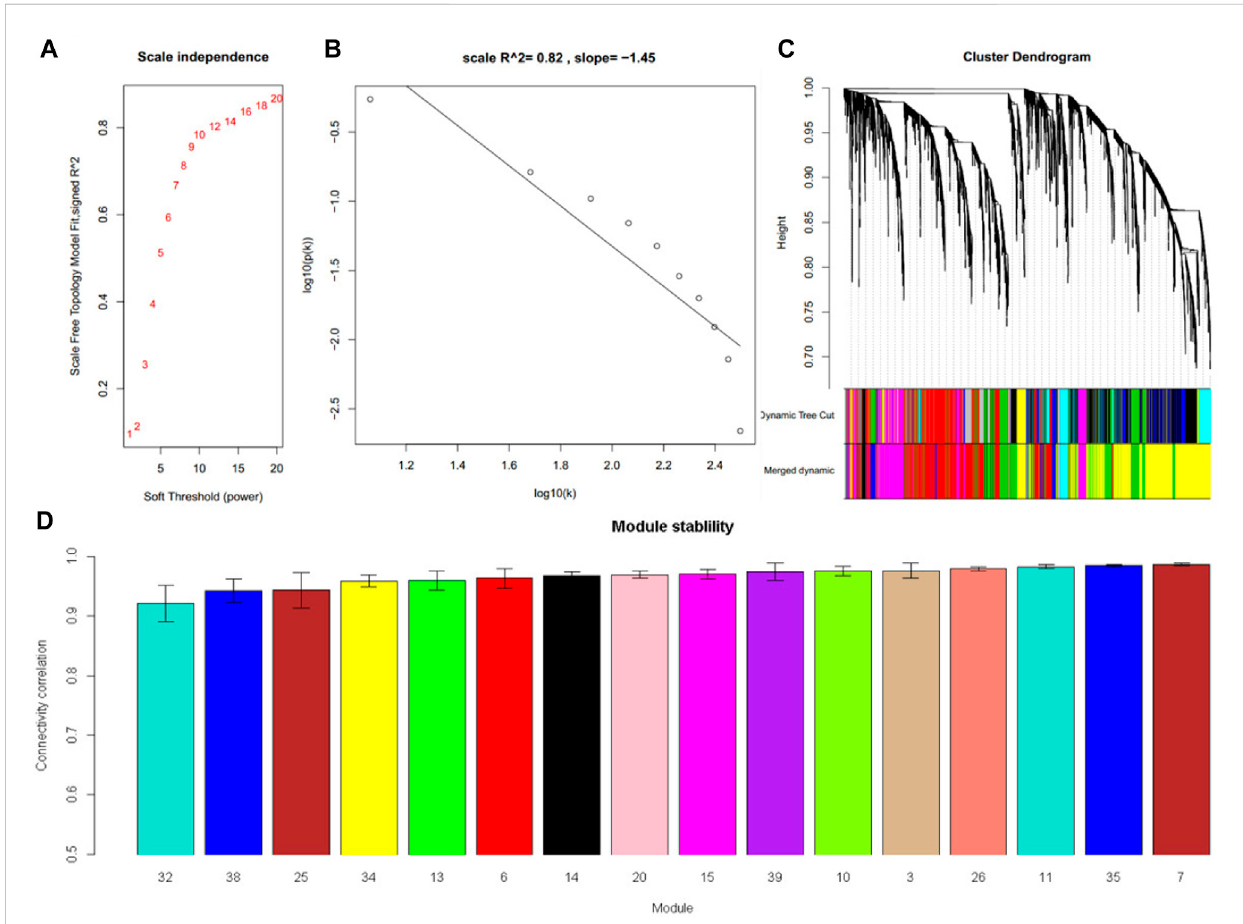
FIGURE 2 Sixteen modules were identi fi ed in the NAFLD dataset GSE135251. (A) The relationship between choosing power and corresponding scale-free topology model fi t R 2 (B) When power was set at 16, the constructed network follows a power law. (C) Cluster dendrogram shows the partition of genes into co-expressed modules with different colors (D) The module stability was tested by sampling half of the samples. The stability was expressed as the correlation of intramodule connectivity between the original one and the sampled